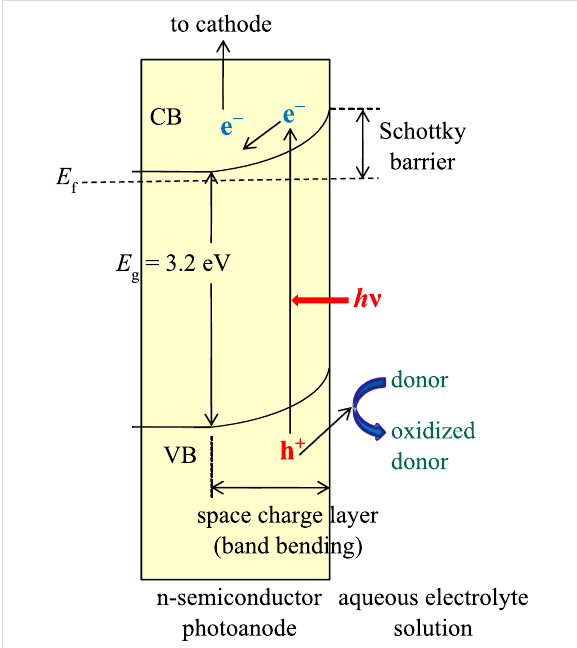
Figure 3: Formation of a Schottky barrier (junction) in an n-semicon- ductor photoanode at the interface with aqueous electron donor/elec- trolyte solution. E f = Fermi level, E g = band gap, VB = valence band, CB = conduction